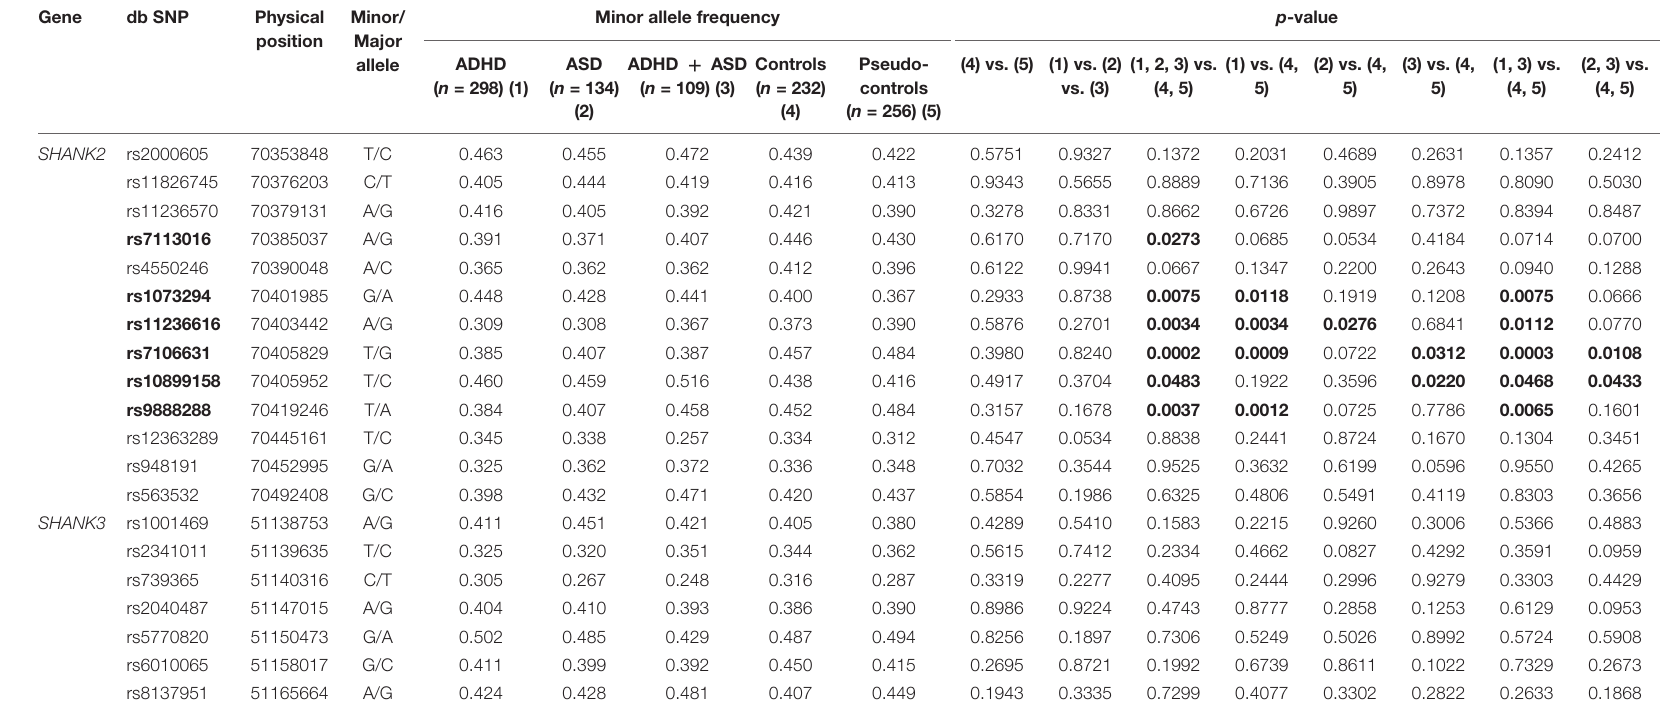
TABLE 1 | Allelic association analysis of SNPs in SHANK genes.